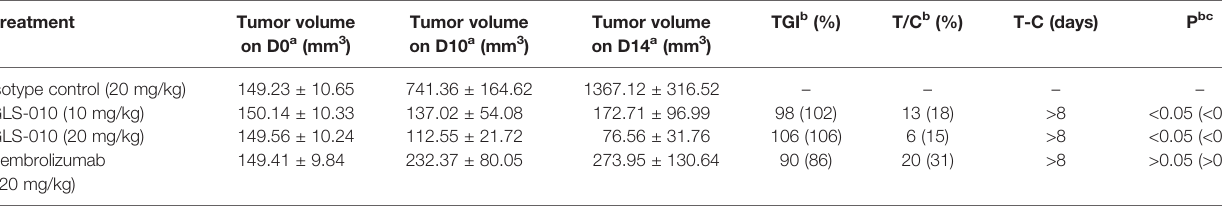
TABLE 2 | Tumor-suppressing effects of GLS-010 in hPD-1KI MC38 tumor-bearing mice. Treatment